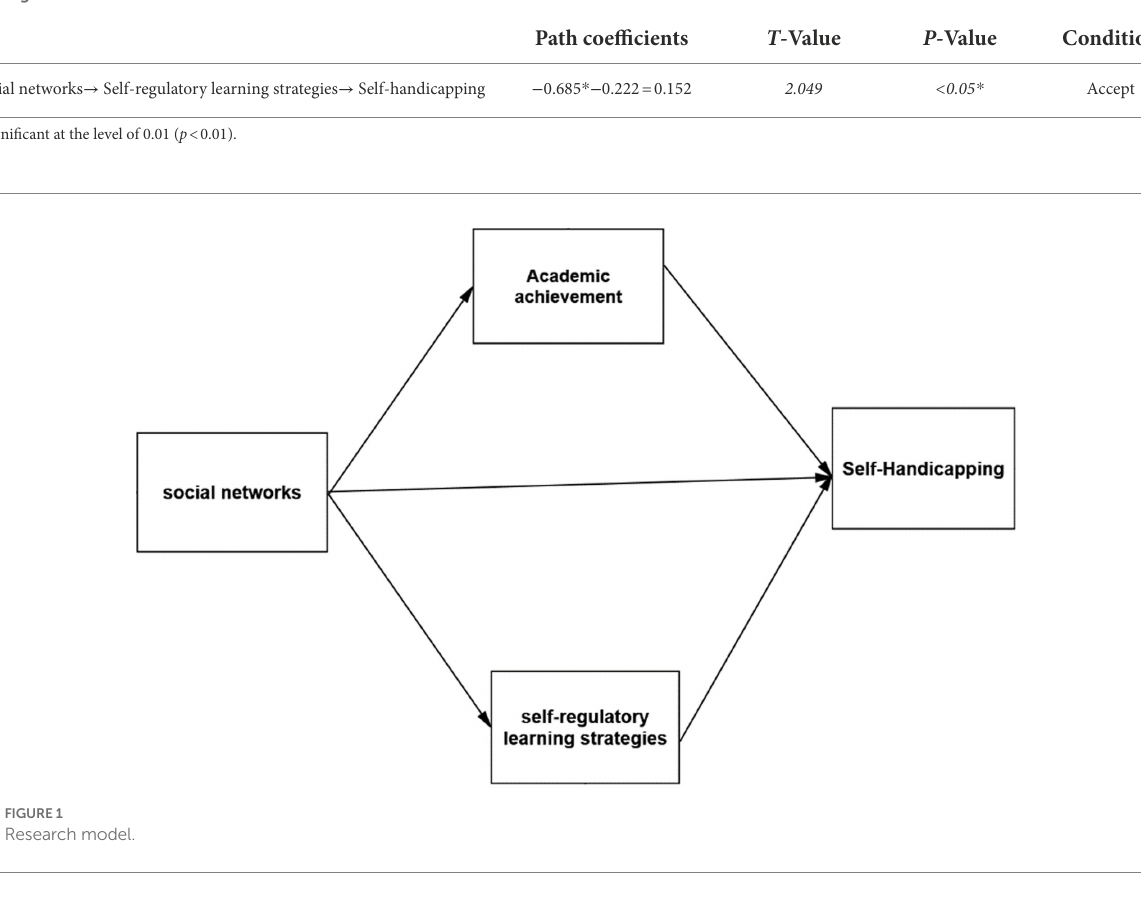
TABLE 5 Investigating the relationship between social networks and self-handicapping with the mediating role of self-regulatory learning